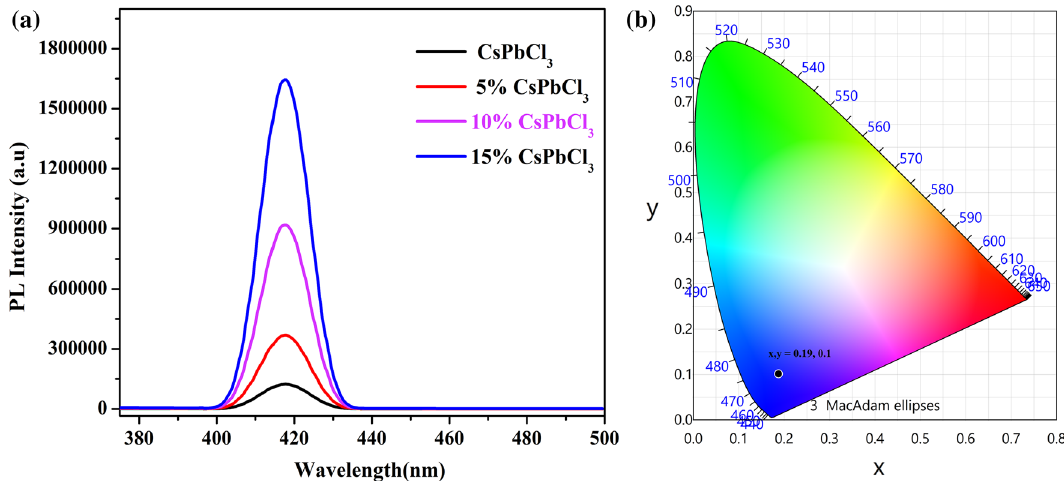
Figure 9. ( a , b ) The emission spectrum and CIE diagram of CsPbCl 3 and Co:CsPbCl 3 ,